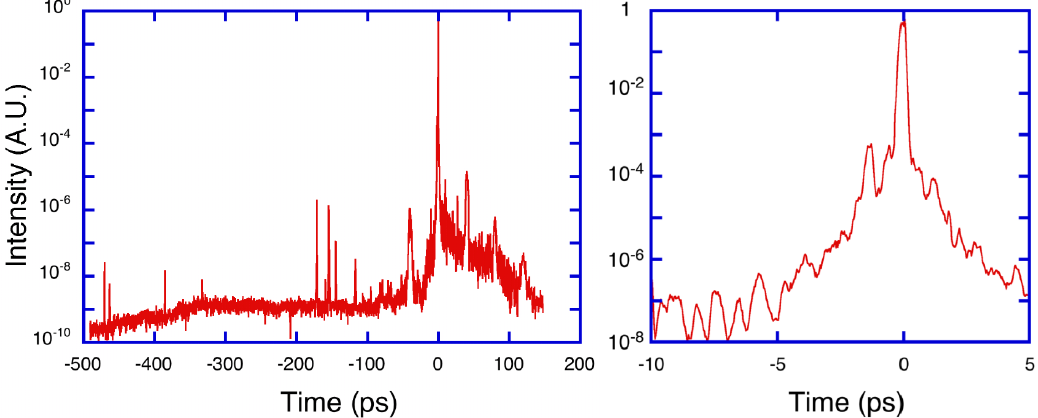
Figure 8. Cross-correlation curve (left) showing the detailed temporal structure of the laser pulse in the 500 ps window before the main pulse. The plot on the left shows that intensity of the amplified spontaneous emission is just above 10 − 9 of the peak intensity. The plot on the right shows the detail of the curve in the ps domain, just before the peak intensity.